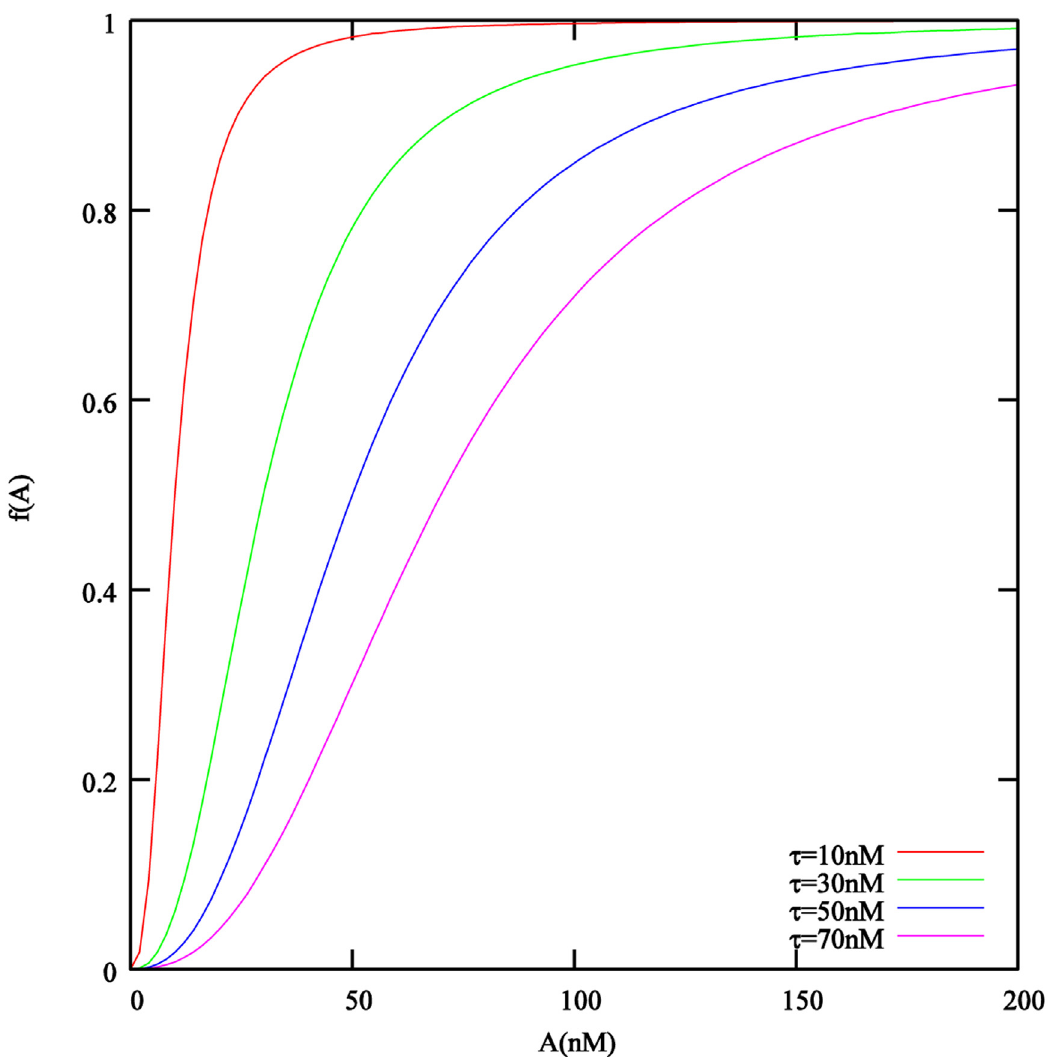
Fig 2. The effect of the local autoinducer concentration A on the autoinducer production rate and the dispersal rate is described by the Hill function f ( A ) = A n /( τ n + A n ). Plotted here for the degree of polymerization n = 2.5 that was obtained in [24] and is used in the simulations later